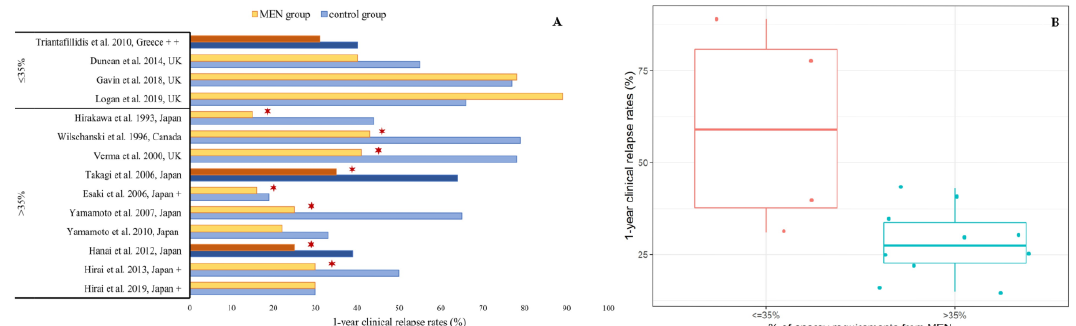
Figure 1. ( A ) Comparison of 1-year clinical relapse rates in patients using MEN against those who did not use MEN in studies reporting the amount of MEN formula consumed ( ≤ 35% /> 35% of energy requirements). indicates statistically significant differences in clinical relapse rates between MEN group and control group in the total duration of each study. Dark colored bar charts indicate RCTs. + Clinical relapse rates in Esaki et al., 2006, Hirai et al., 2013 and Hirai et al., 2019 are approximate numbers extracted from figures. ++ only 6-month relapse rates were available. ( B ) Median clinical relapse rates in patients consuming MEN, based on amount of formula consumed ( ≤ 35% /> 35% of energy requirements).